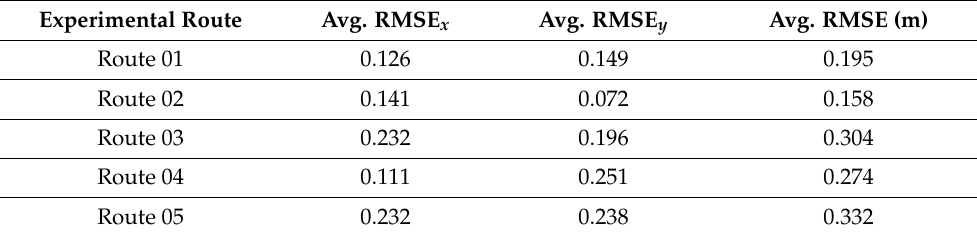
Table 6. TBM-based Hybrid Approach: The Average RMSE of Routes 01~05. Experimental